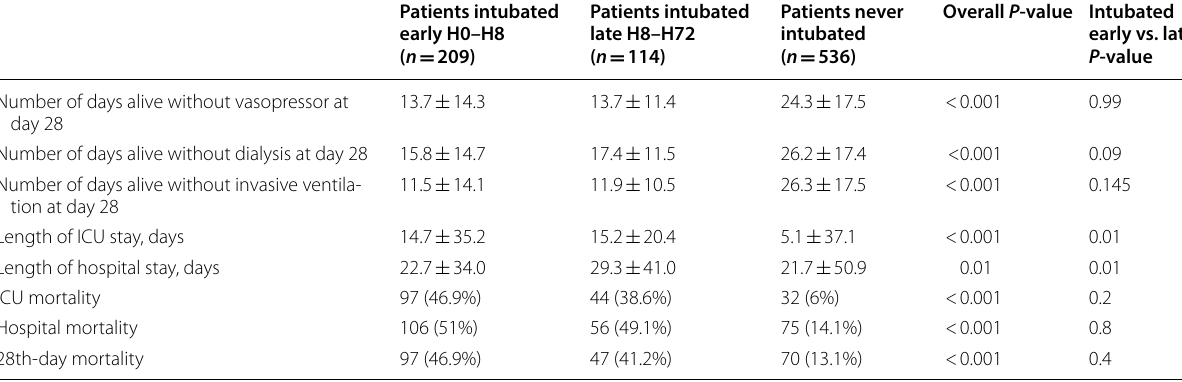
Table 3 Patient’s outcome according to intubation during the ICU